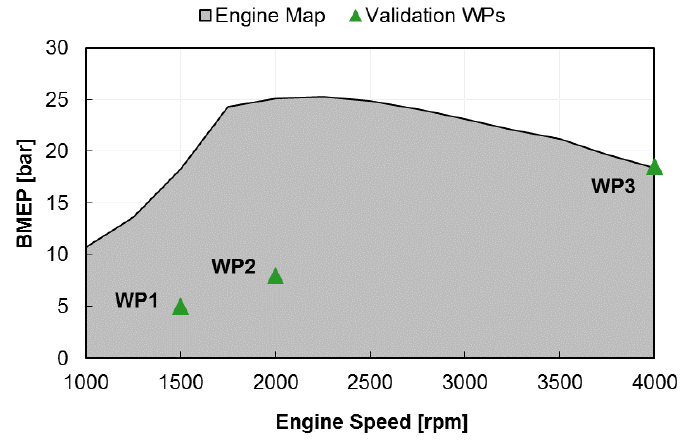
Figure 2. Engine selected WPs (Working Points) on the engine map. Table 2. Selected engine WPs.